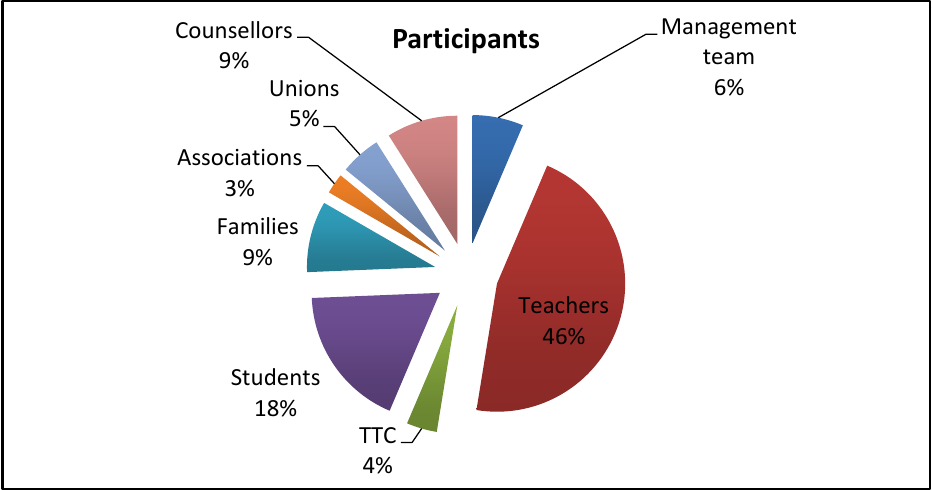
Figure 1. Participants in the study by groups. Source: Prepared by the